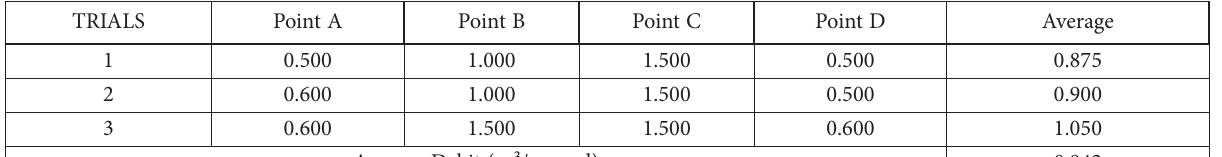
Table 10. Average debit of the River